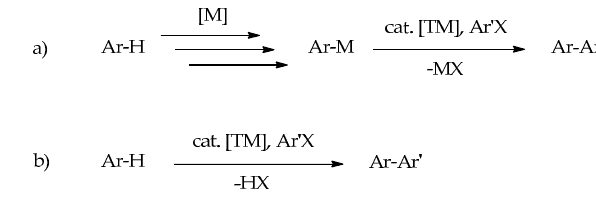
Figure 1. Coupling reactions: ( a ) Traditional cross-coupling; and ( b ) direct arylation.